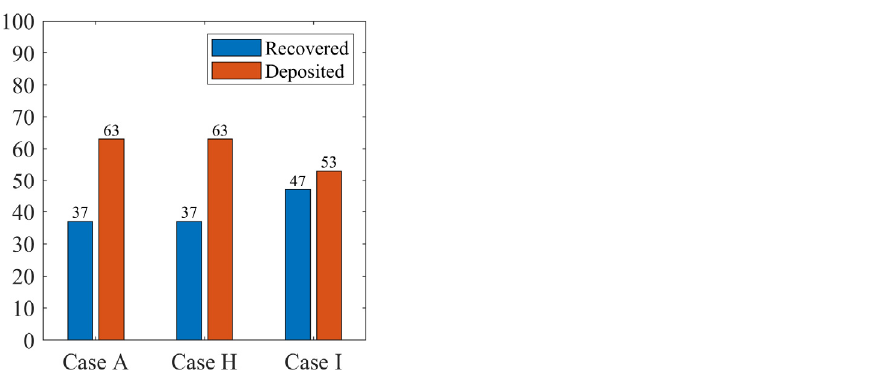
Figure 18. Product recovery at outlet and deposition in the dryer for cases A, H and I.